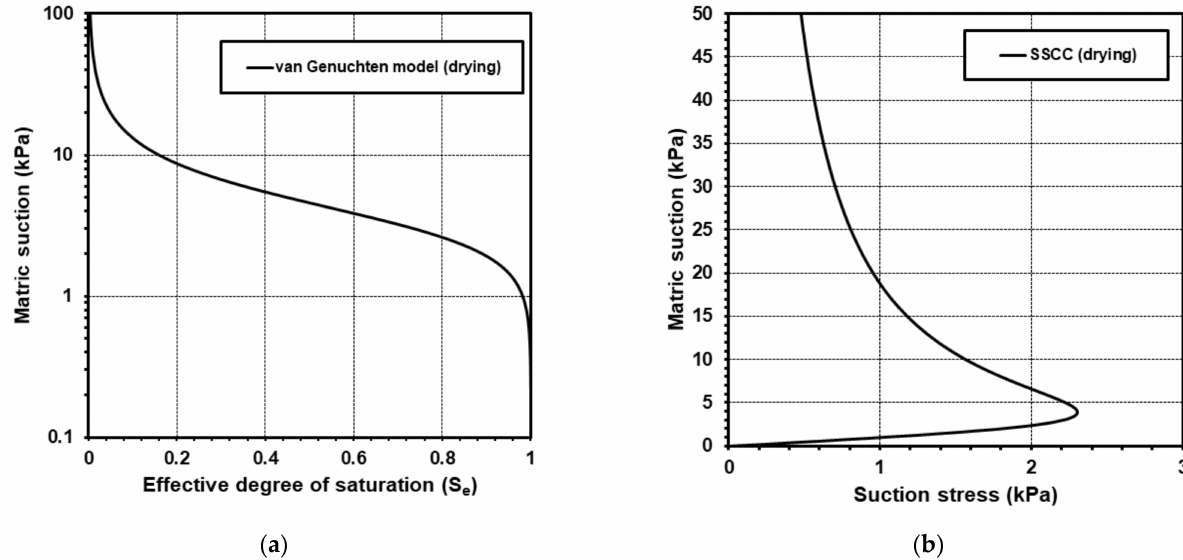
Figure 10. Unsaturated soil properties of the analysis domain area: ( a ) Soil-water characteristic curve; ( b ) Suction stress profile.